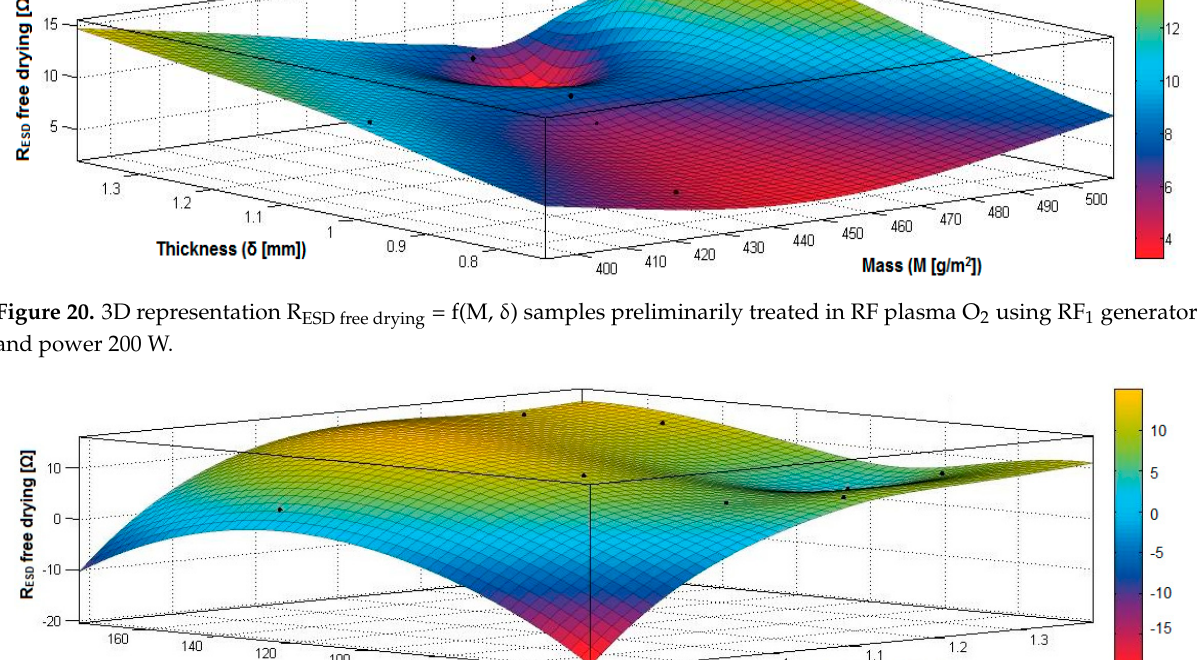
Figure 21. 3D representation R ESD free drying = f(Pa, δ ) samples preliminarily treated in RF plasma O 2 using RF 1 generator and power 200 W.